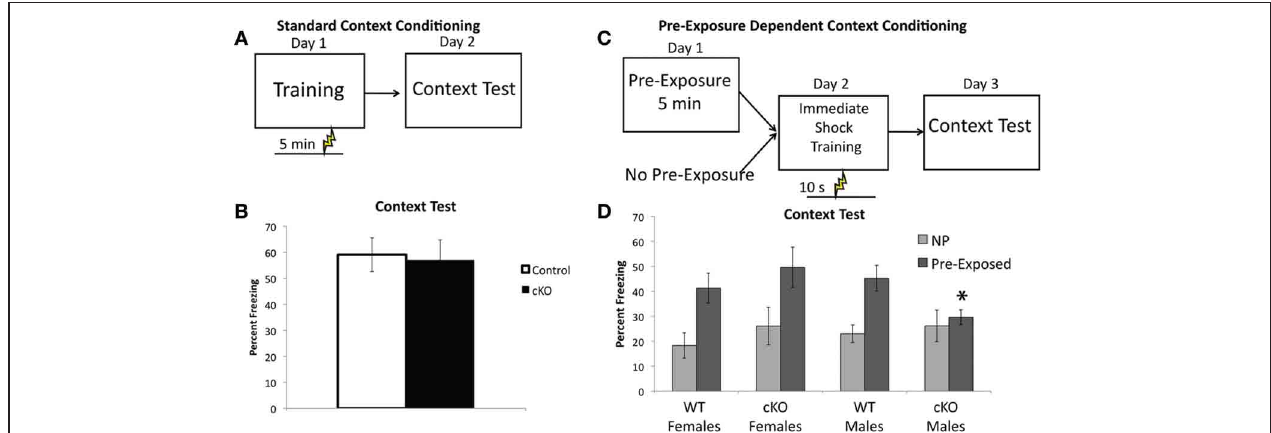
FIGURE 6 | DNMT1-cKO mice a sex-specific impairment of pre-exposure-dependent, but not standard contextual fear. (A) Experimental design for the Standard Contextual Learning. Shock is administered 5min after placement in the conditioning chamber on the training day. Animals are returned to the context 24h later for a context test. (B) Percent freezing in during the context test for the standard context fear task. (C) Experimental design for the Pre-exposure-dependent